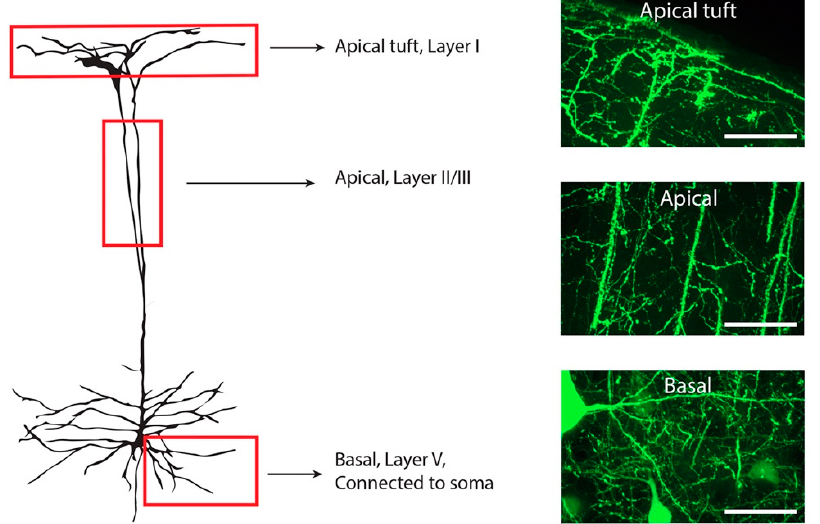
Figure 1. Illustration of a Layer V YFP-H positive neuron within the motor cortex. Three different regions were included for spine quantification (red boxes). All apical tuft dendrites were quantified in layer I, identified by the clearly visible meninges membrane. Apical dendrites within cortical layer II/III were identified through location of the cortical layers and only the main apical dendrite included in quantification. Basal dendrites in layer V were identified as directly connected to a YFP-H pyramidal cell soma. Dendritic spines on the entire visible dendritic tree were counted from a single somatic branch point. Scale bars 50µM.